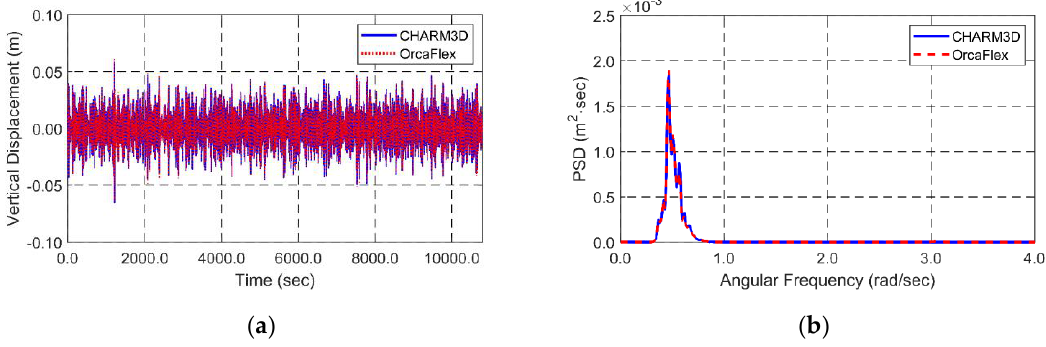
Figure 8. Time histories ( a ) and spectrum ( b ) of vertical displacement of the tunnel in the middle location under the 100-year-strom waves.